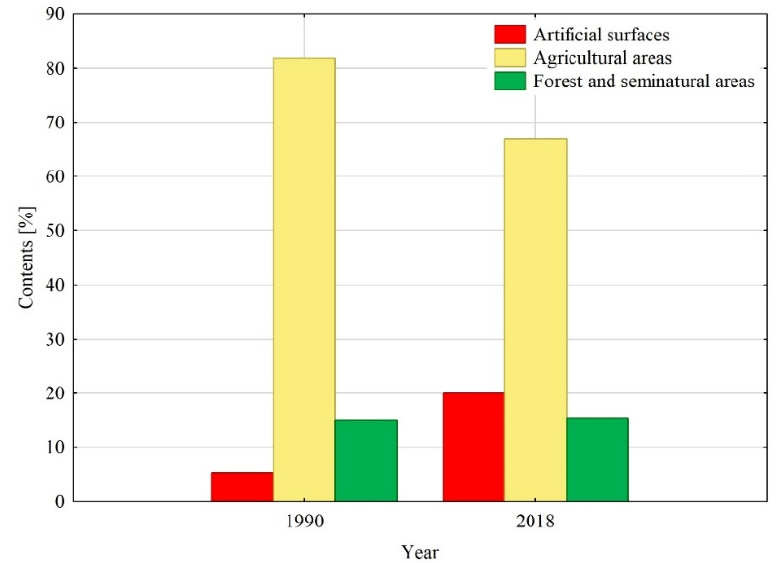
Figure 4. Land use of the Wirynka catchment for two years (1990 and 2018).